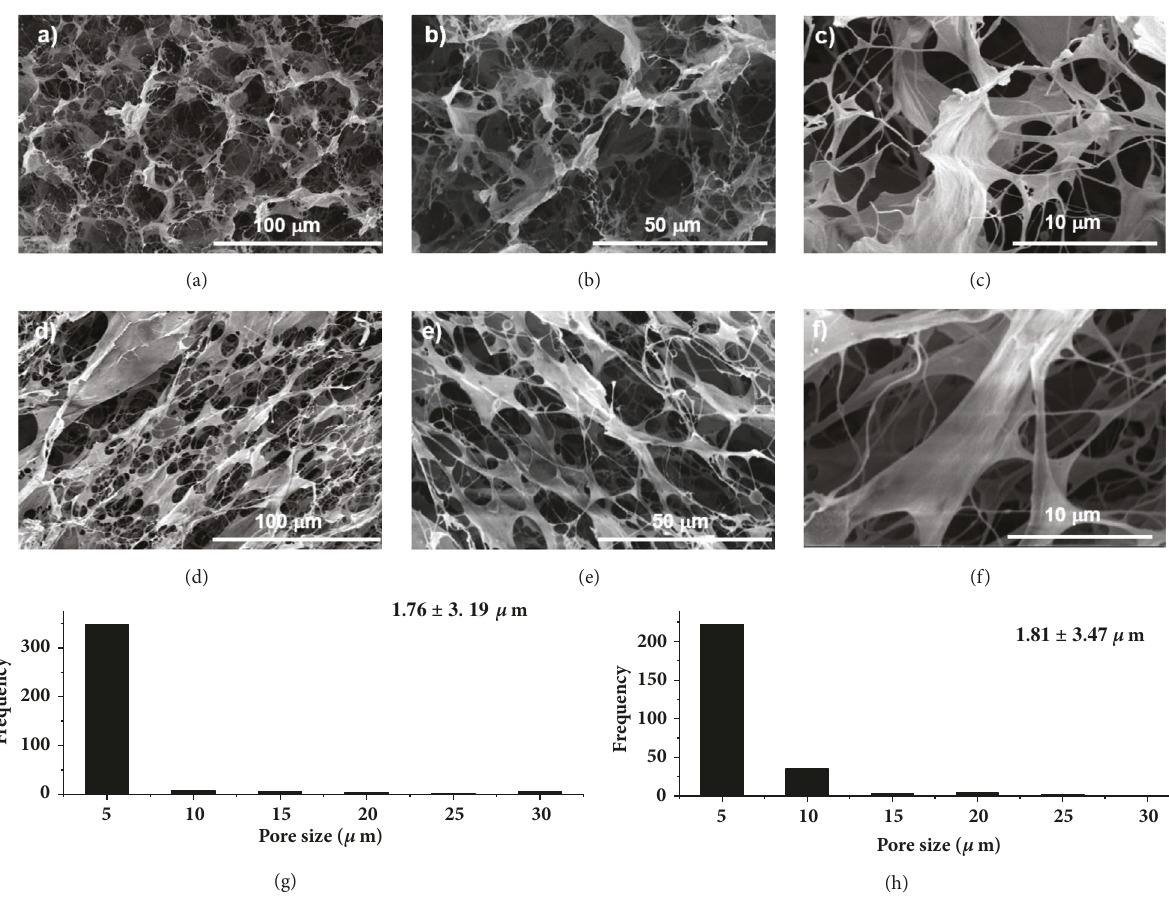
Figure 3: Scanning electron micrographs of transverse (a–c) and longitudinal (d–f) cross sections of swollen and then freeze-dried BSH (with average pore size 1.92 ± 3.83 𝜇 m) at different magnifications. Size distribution of macropores (g) and (h) and of transverse (a) and longitudinal (d) cross sections.